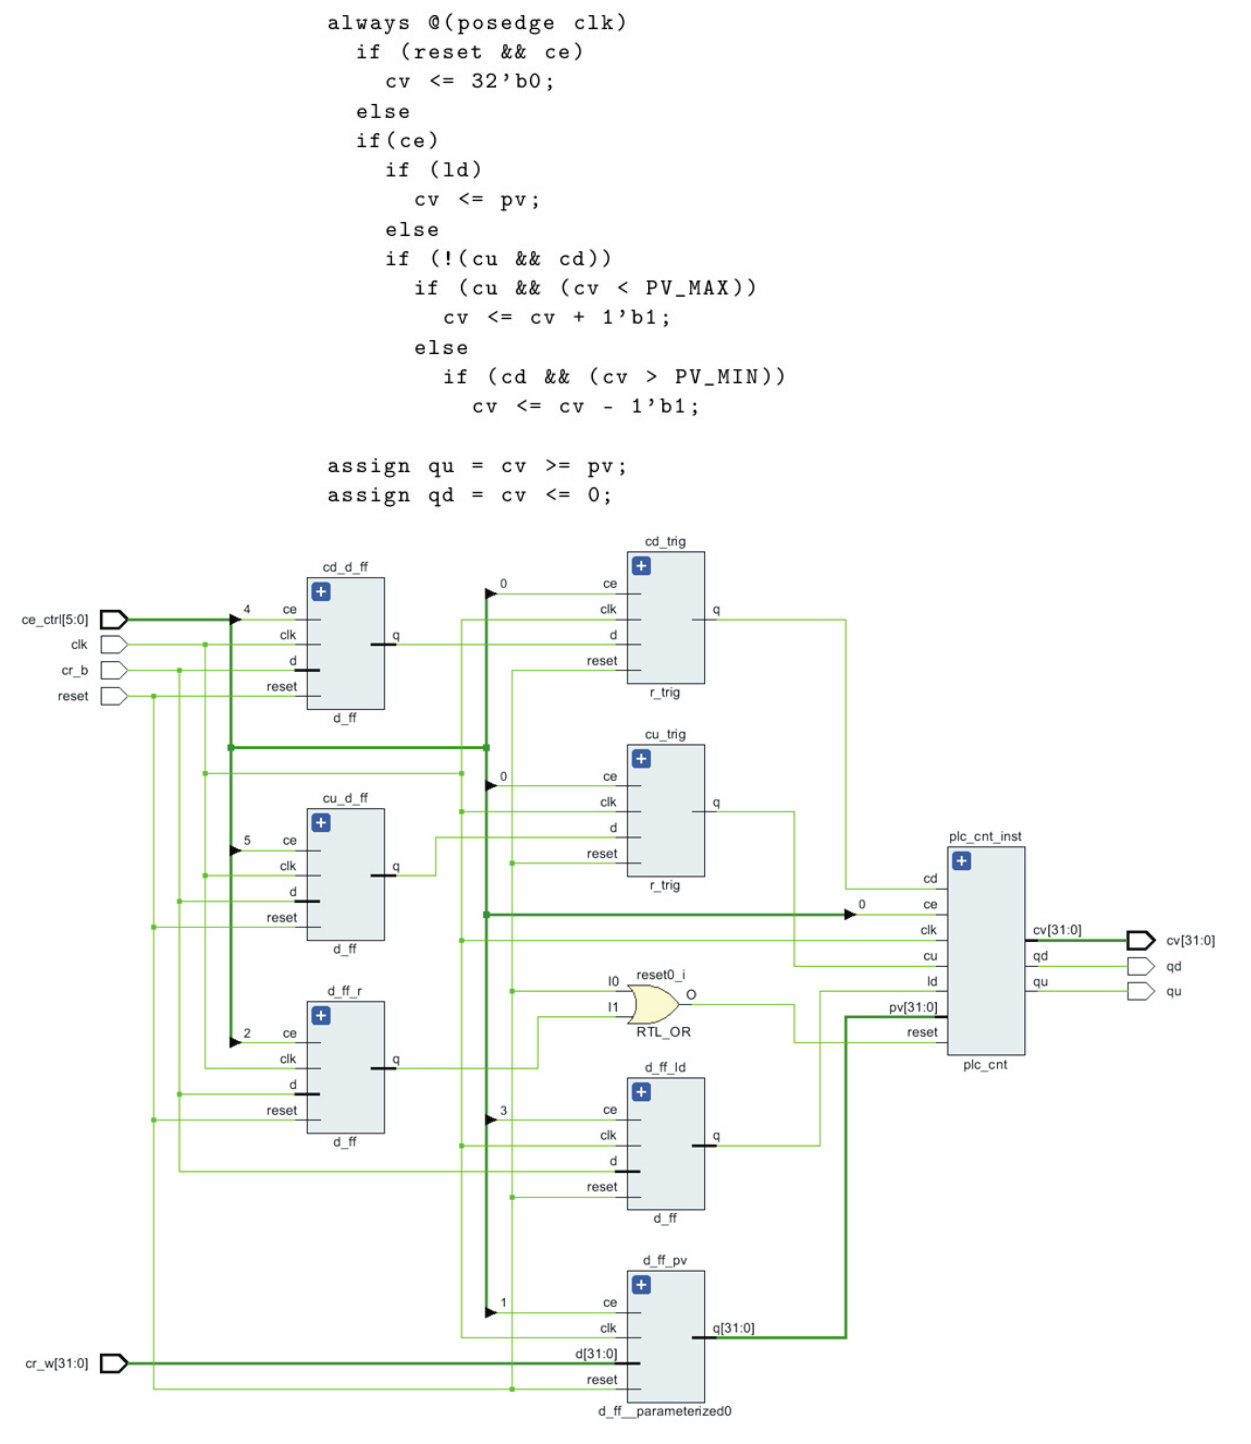
Figure 9. RTL schematic of the proposed counter